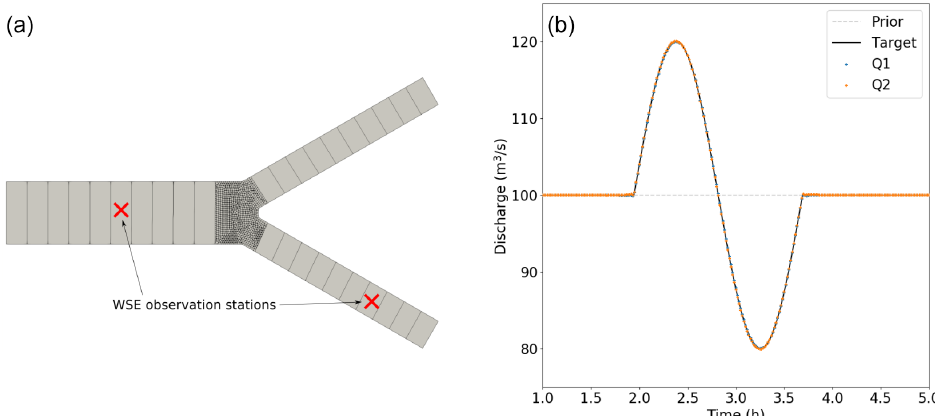
Figure 10. Inflow hydrographs inference on confluence synthetic case in observation setup (b) with one station on a reach upstream of the confluence and one observing mixed flows downstream in the 2D part. Given sufficient observability and an unbiased prior, inferred hydrographs (in blue and orange) are both at target (blue, total overlap). The flow is subcritical with a maximum Froude value of 0 .